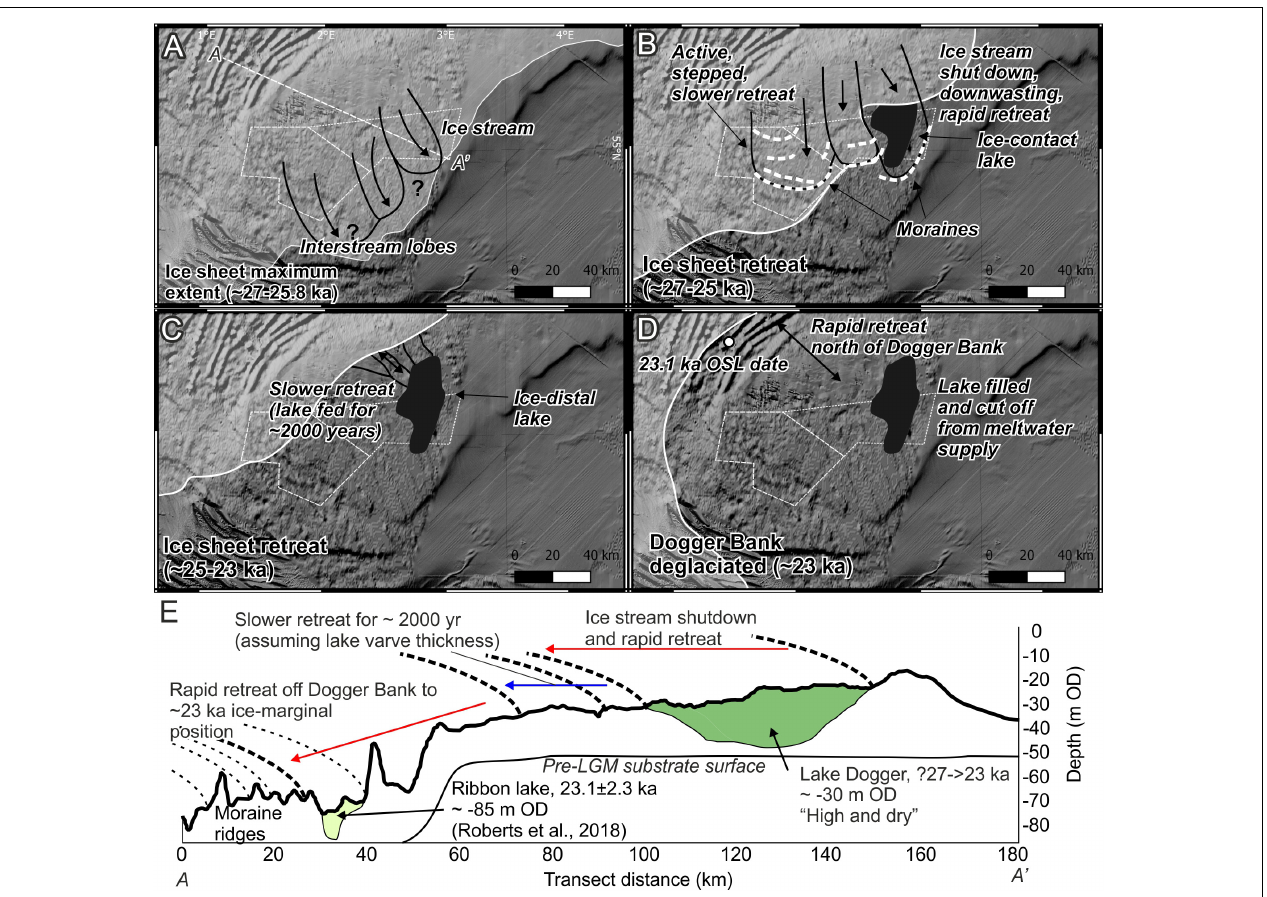
FIGURE 11 | Wider implications and approximate timing of observed ice-sheet retreat in the study area. (A) Ice at its maximum extent, showing the locations of possible ice streams and interstream lobes. The inferred lobate nature of the margin is shown schematically. (B) Initial ice-sheet retreat and ice-contact proglacial lake stage. Moraines in Tranche A are from Phillips et al. (2018). (C) Continued retreat and ice-distal proglacial lake stage, with postulated channels draining from the ice sheet into the lake. (D) Final rapid retreat off the northward-dipping inverse slope and isolation of the proglacial lake. The 23.1 ka OSL date is from Roberts et al. (2018). (E) Bathymetry profile through Dogger Bank to the ribbon lake of Roberts et al. (2018) highlighting approximate ice-sheet retreat rates and the higher, older lake on top of Dogger Bank. Bathymetry data: GEBCO